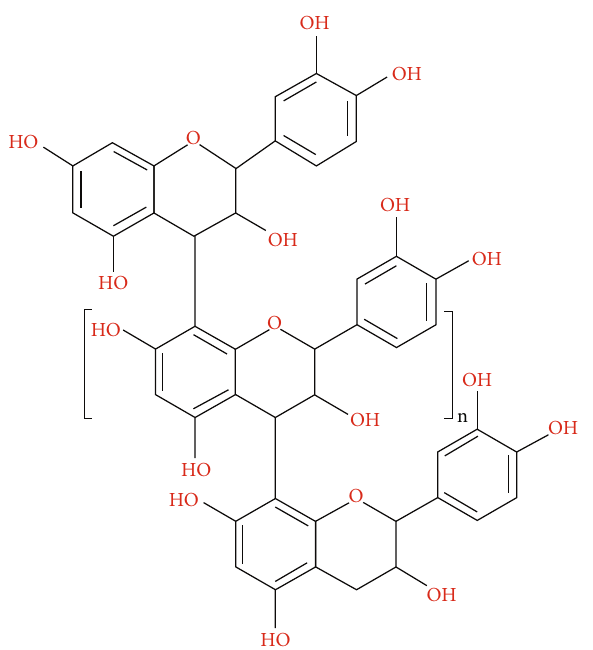
Figure 3: Instruments used in the experiment.